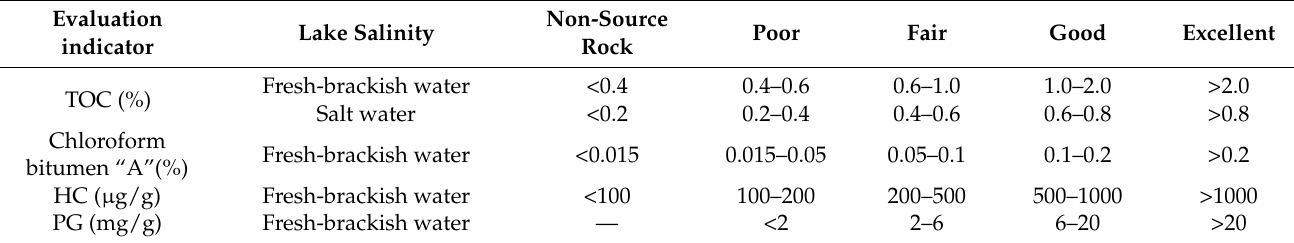
Table 3. Evaluation index of organic matter abundance of terrestrial source rocks